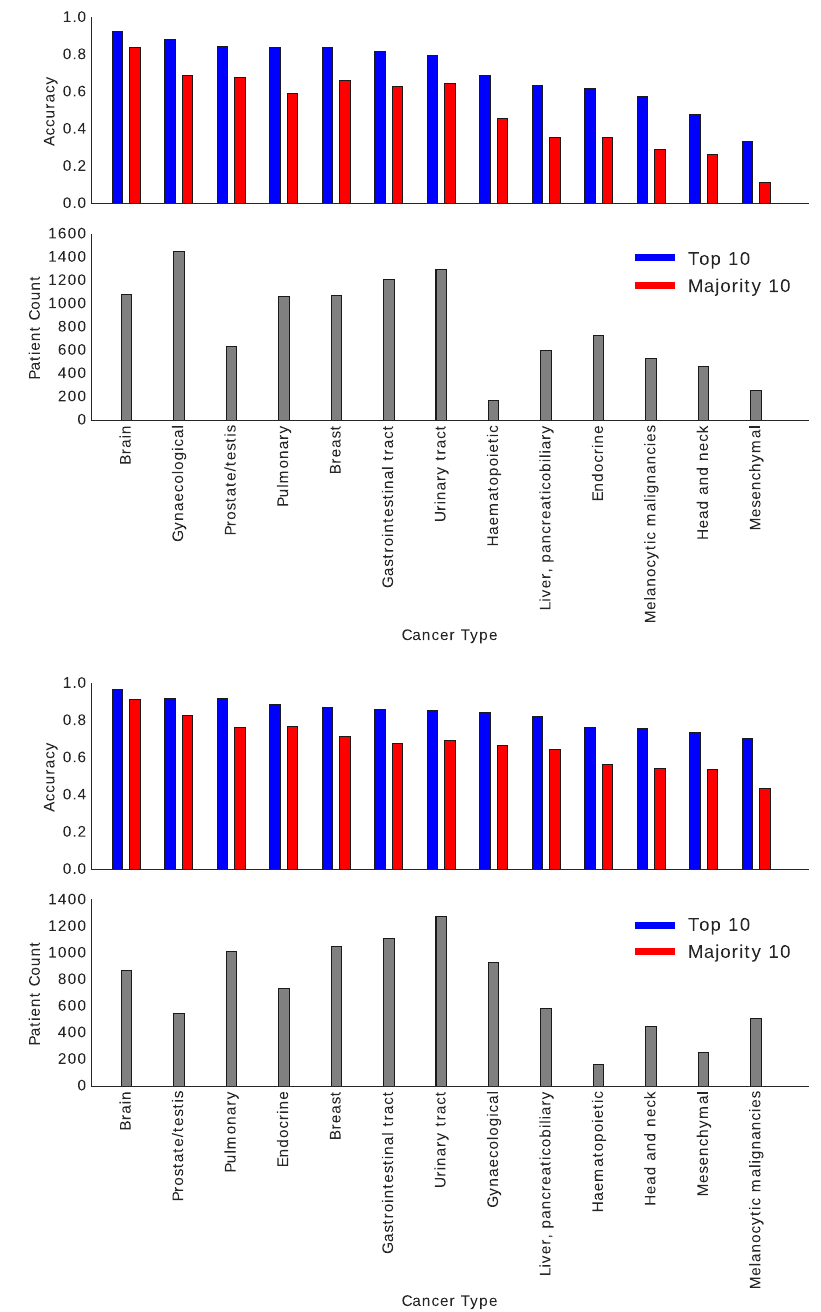
Fig. 1 Horizontal search for frozen sections (top) and permanent diagnostic slides (bottom). Details are demonstrated in Tables 1 and 2 in the